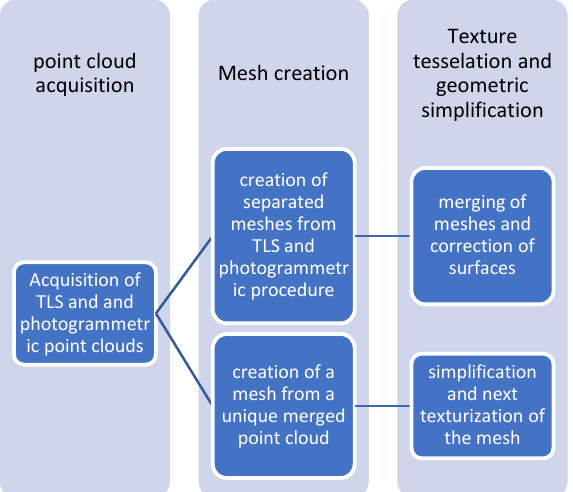
Figure 5. the 3D modelling tested solutions.